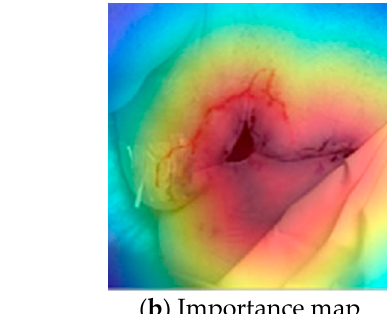
2.6%, diabetic: 58.2% (Pressure injury).